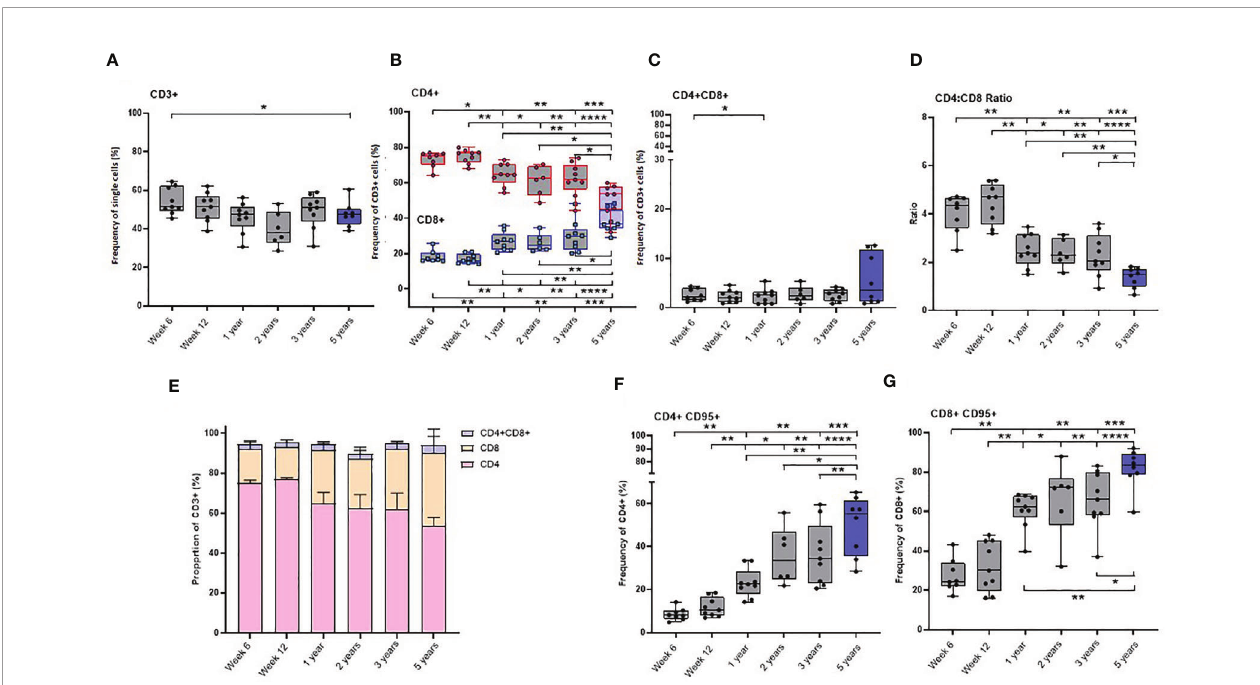
FIGURE 4 | Age related changes in lymphocyte and memory cell subset populations. Plots (A – D) show the frequency of lymphocytes subsets, (E) proportions of CD4+, CD8+ and CD4+CD8+ lymphocytes (F) CD4+CD95+ and (G) CD8+CD95+ memory cells measured in naïve macaques from infancy (6 weeks of age) through to three years (grey) compared with young adult macaques aged between 3.7 and 5.2 years of age (blue). Box plots show the group median +/- the inter-quartile range, with minimum and maximum values connected by whiskers. Signi fi cant differences measured by Wilcoxon matched-pairs rank test or Mann-Whitney U-test between the groups are indicated. *p < 0.05, **p < 0.01, ***p < 0.001, ****p <